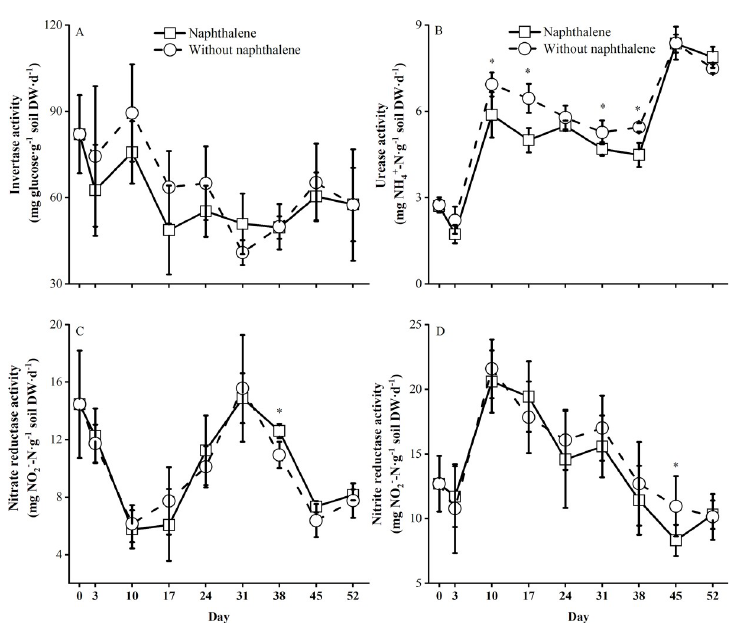
Fig 5. Soil enzyme activities in subalpine forest soil microcosms treated with and without naphthalene. The values represent the means ± the standard error (SE) (n = 5). Asterisks indicate significant ( � P < 0.05) differences between the treatments with naphthalene and without naphthalene at the same sampling